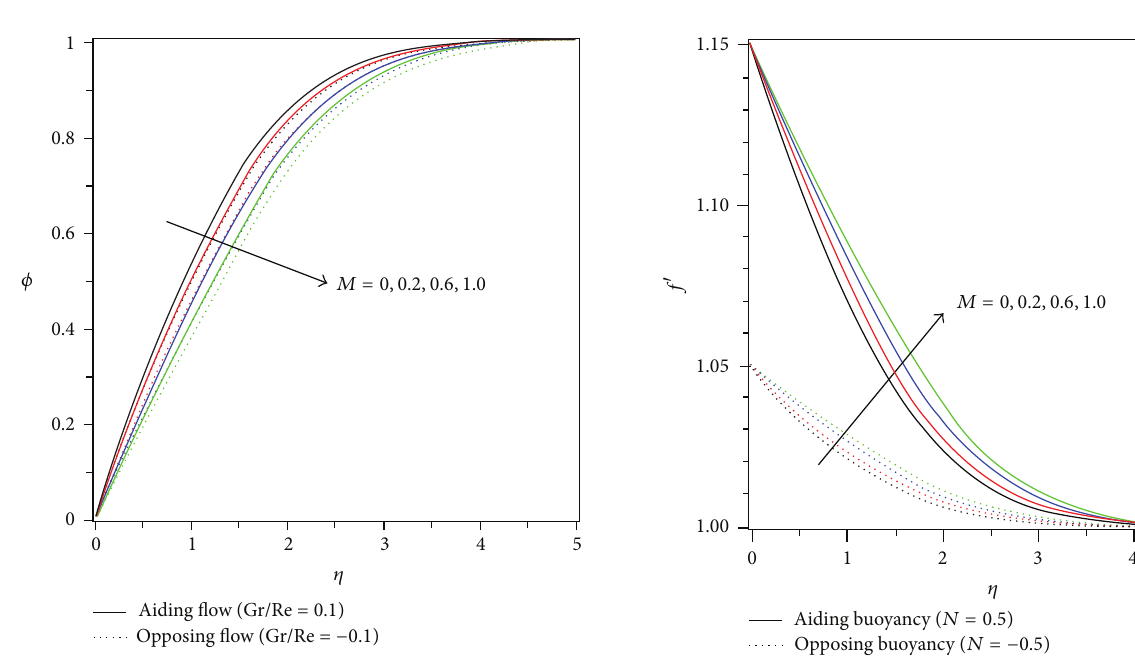
Figure 4: Concentration profile for both aiding and opposing external flows for different values of 𝑀, 𝑁 = 0.5 , Df = 0.02 , Sr = 0.2 , Gr = 0.1 , and Le = 1.0 .